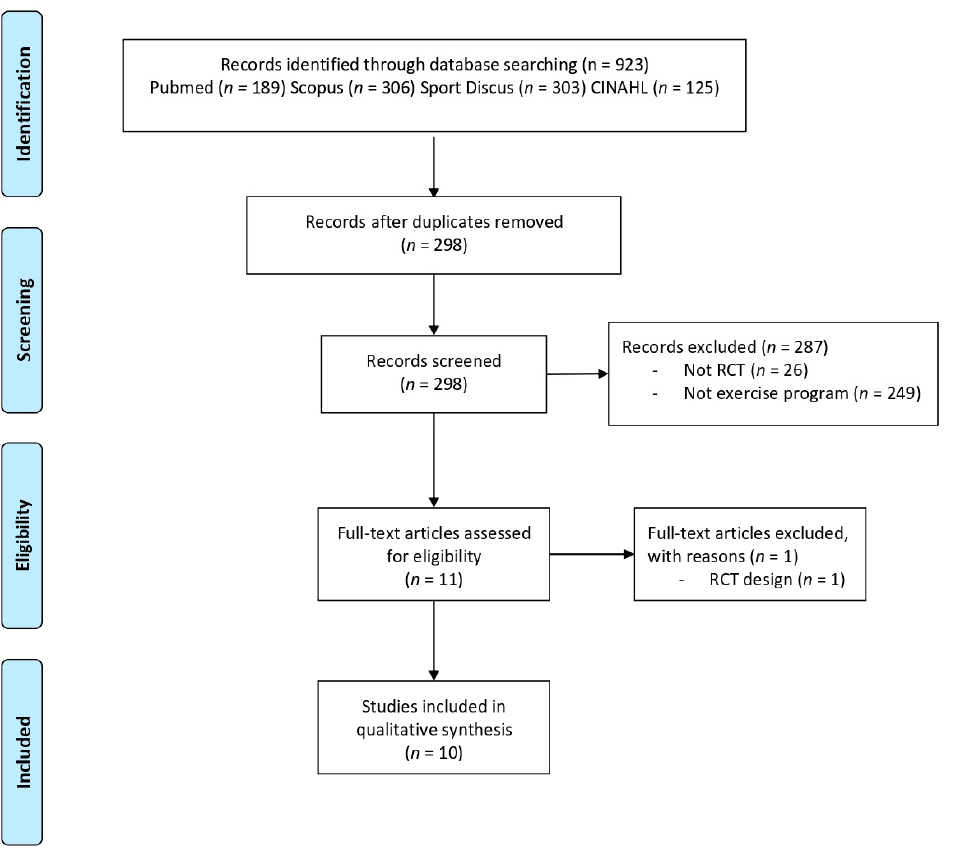
Figure 1. PRISMA flow